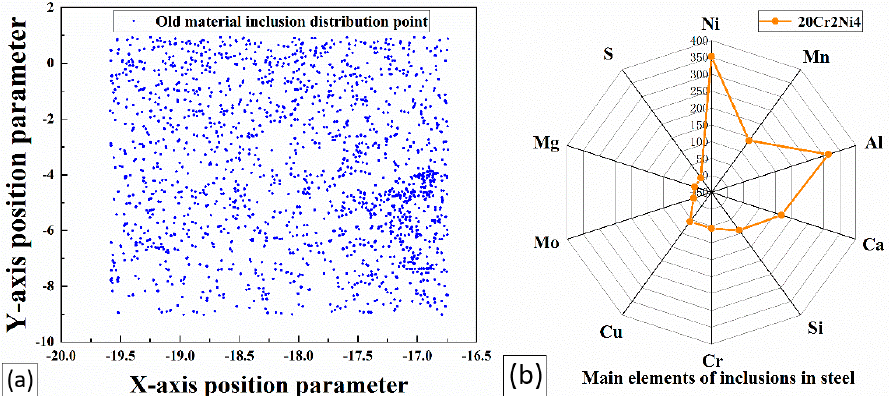
Figure 5. Characterization of steel inclusions: ( a ) overall distribution location map, ( b ) the number of major element inclusions in the area.